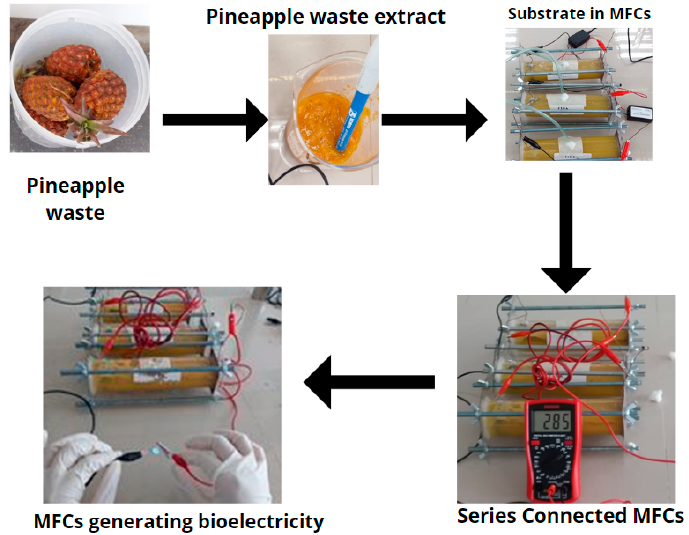
Figure 6. Mechanisms of the bioelectricity generation process from pineapple waste.